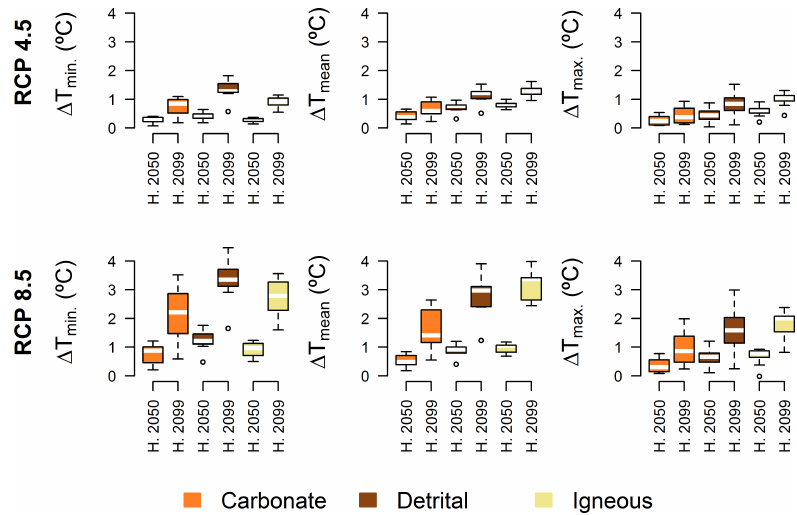
Figure 9. Distributions of (cid:49)T min , (cid:49)T mean and (cid:49)T max in relation to lithology for the climate change scenarios RCP4.5 and RCP8.5 in H-2050 and H-2050. The reference period corresponds to the simulated period